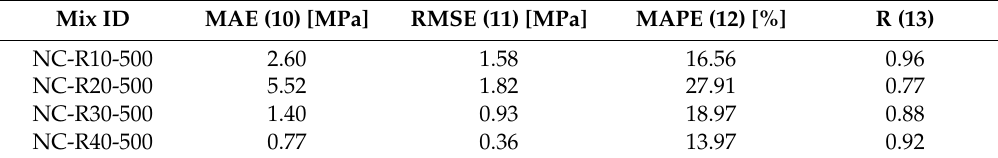
Table 8. Statistical performance of Constitutive models for experimental study.